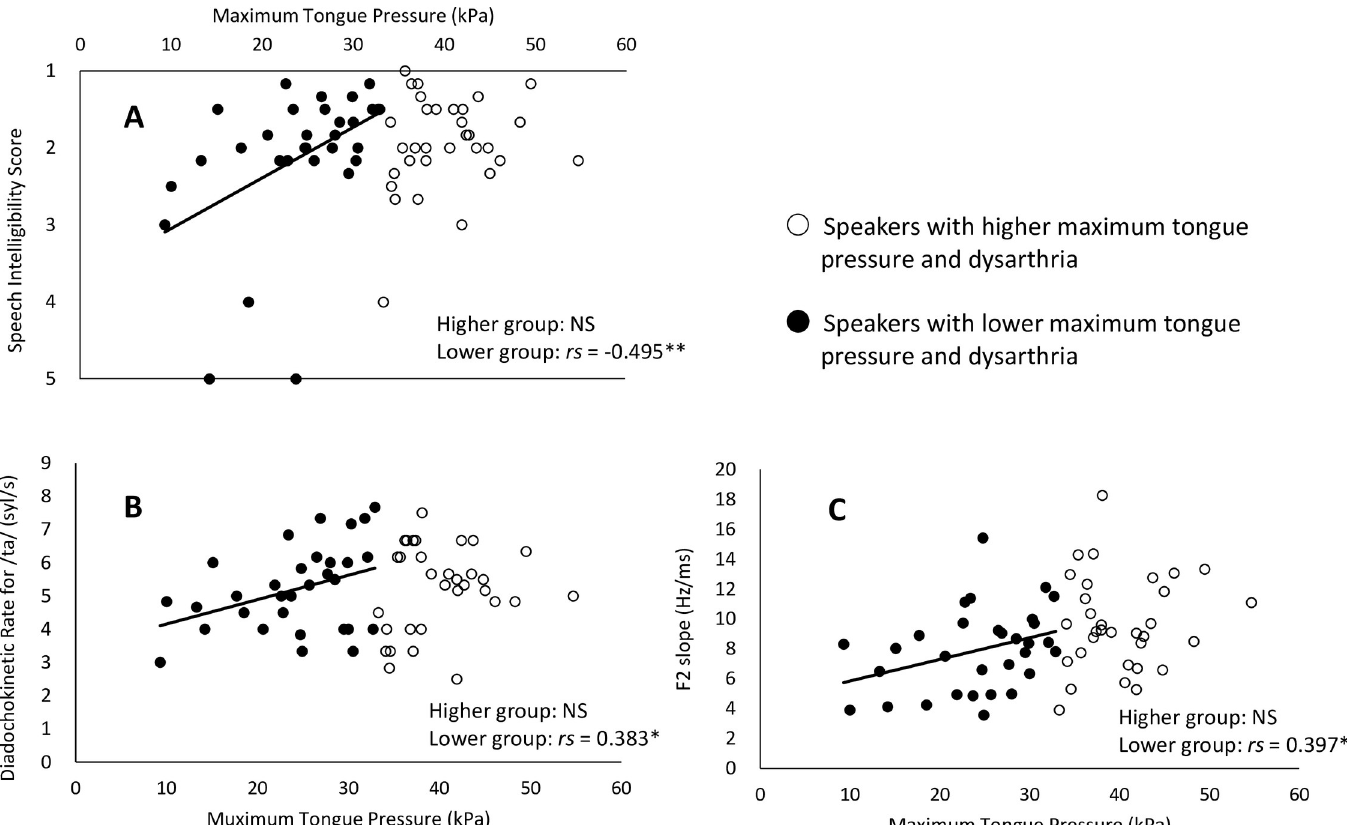
Fig 4. Bivariate scatter plot and best-fit regression line of the maximum tongue pressure and speech-related variables in the two speakers with dysarthria groups divided according to the maximum tongue pressure by median. (A) speech intelligibility score, (B) diadochokinetic rate for /ta/, (C) second formant (F2) slope. � p < 0.05, �� p < 0.01. Speakers with lower maximum tongue pressure and dysarthria (lower group) tended to have lower speech-related variables, such as lower maximum tongue